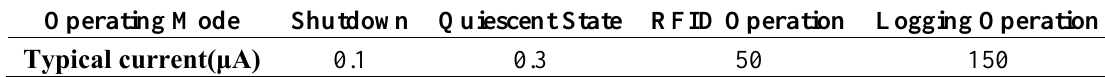
Table 1. SL900A working current in all modes of